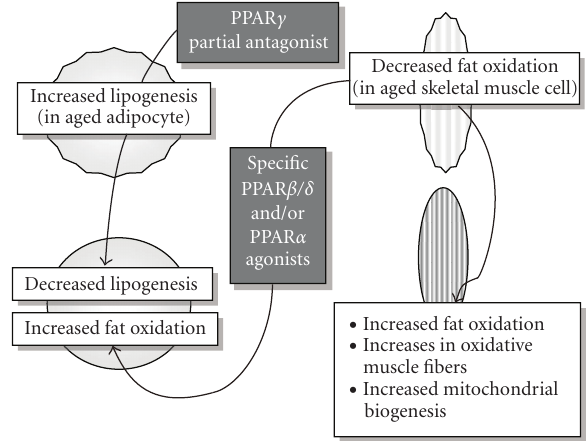
Figure 2: In aging organism, two important sites regarding the energy metabolism, adipocyte with the increased lipogenesis, and skeletal muscle with the decreased fat oxidation are shown. Possible future therapeutic fields and expected beneficial alterations are also